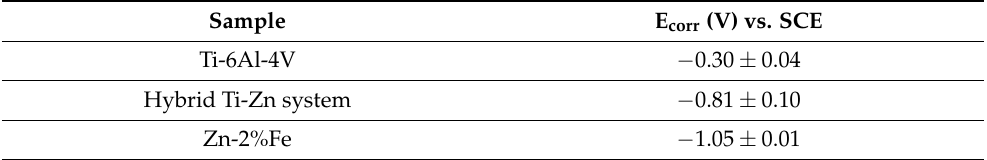
Figure 6. Open circuit potential analysis of hybrid Ti-Zn system and its constituent materials. Table 4. Open circuit potential measurements with statistical deviations as obtained after 100 h of immersion.